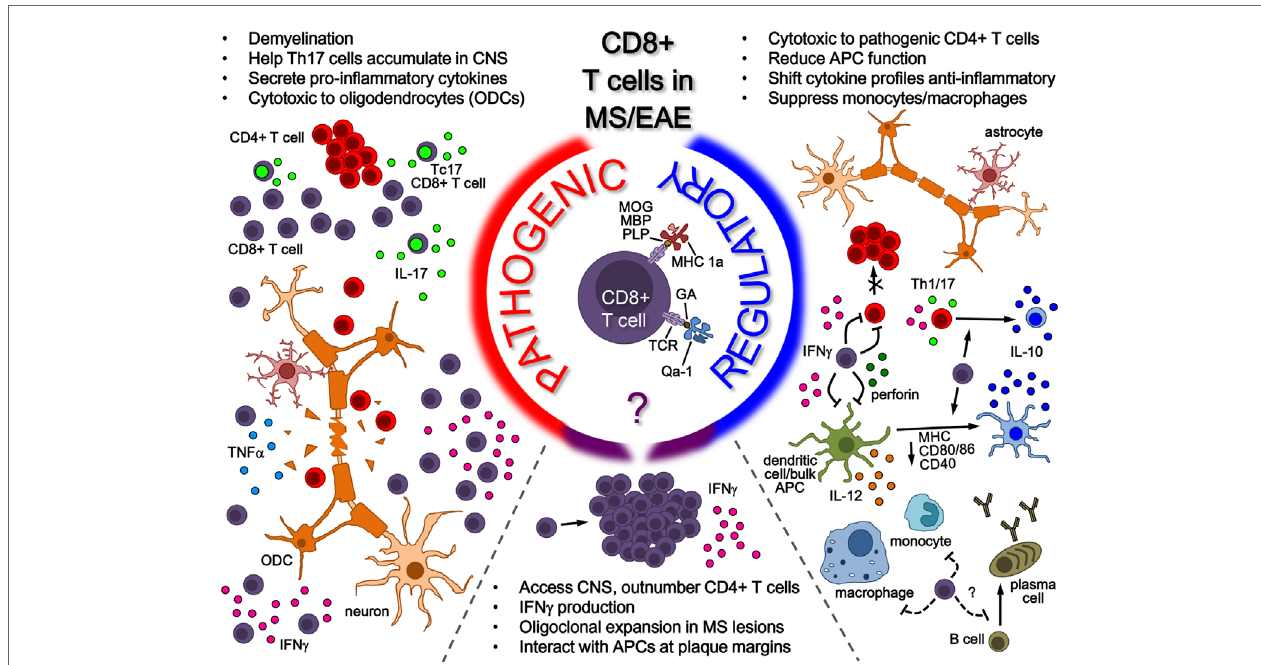
FiGURe 1 | Role of CD8 + T-cells in MS/eAe . While the antigenic specificity of pathogenic CD8 + T-cells remains unknown, their pathogenic function is mainly attributed to pro-inflammatory cytokine secretion (in the peripheral immune system and potentially in the CNS) as well as cytotoxicity toward oligodendrocytes in the CNS. On the other side, several lines of evidence indicate a regulatory role for CD8 + T-cells in both MS and EAE. Neuroantigen-specific autoregulatory T-cells are classically MHC Class I restricted, whereas there are also examples of HLA-E/Qa1-restricted regulatory T-cells that may be naturally occurring or induced through therapy. Mechanisms for CD8 + T-cell-mediated regulation include secretion of cytokines such as IL-10 and IFN γ , cytotoxicity toward pathogenic immune cells and modulation of APC functions, both in the periphery and possibly in the